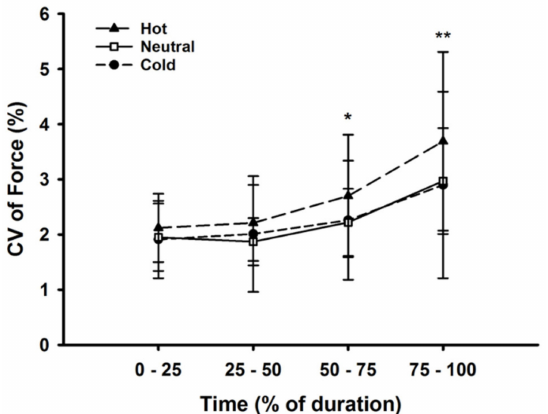
Figure A1. Force variability throughout the fatiguing task. * ( p < 0.05) hot vs. cold. ** ( p < 0.01) hot vs. neutral.